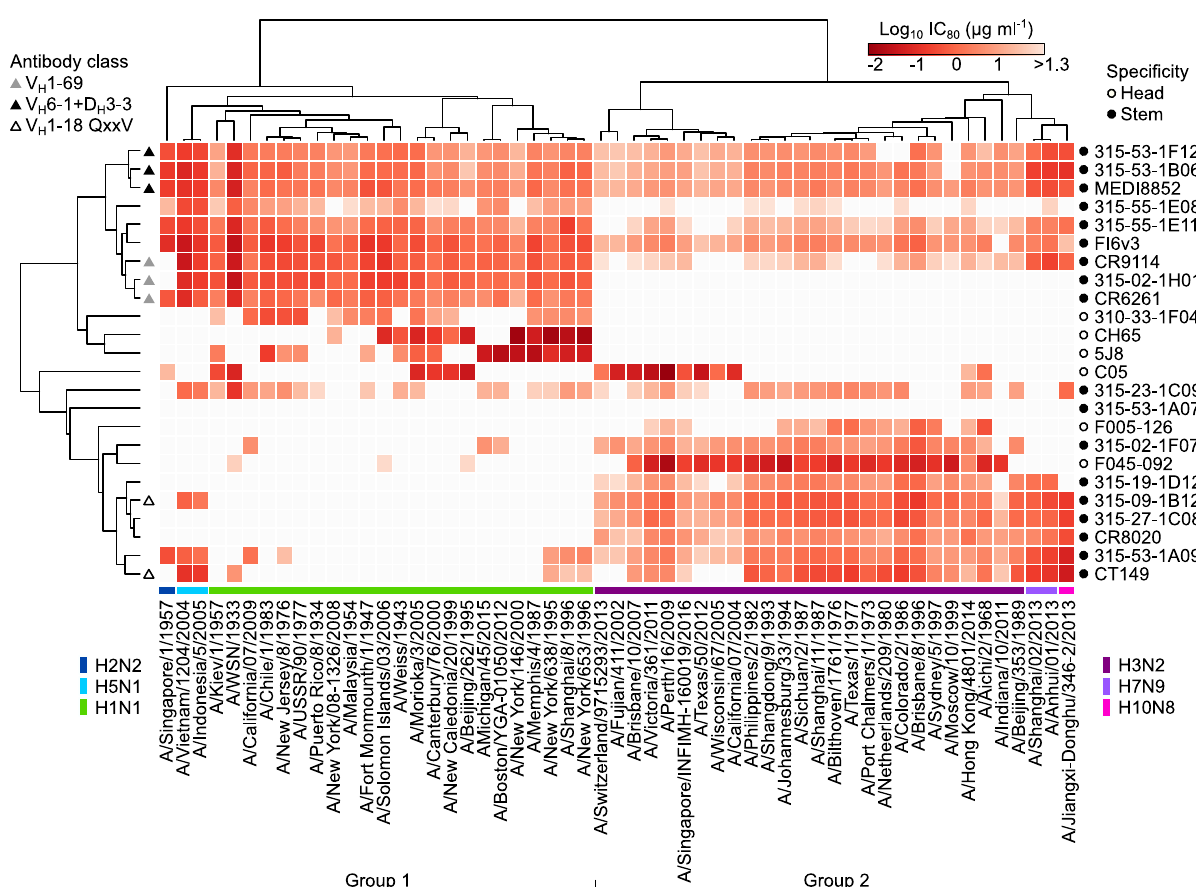
Fig. 5 In-depth neutralization pro fi ling of in fl uenza monoclonal antibodies. Heatmap of neutralization titers (IC 80 μ g ml − 1 ) of 24 monoclonal antibodies against a panel of 55 R3 in fl uenza A viruses. Virus subtypes are color-coded and indicated at the bottom of the heatmap. Open and closed circles indicate speci fi city of monoclonal antibodies and are shown on the right of the heatmap (open, HA head-; closed, HA stem-directed). Convergent classes of bnAbs with speci fi c gene signatures are indicated on the left of the heatmap as triangles (gray, V H 1-69; black, V H 6-1 + D H 3-3; open, V H 1-18 QxxV). Heatmap and unsupervised clustering was made with the ClustVis server (https://biit.cs.ut.ee/clustvis/). Note: H1N1 and H3N2 viruses are R3 Δ PB1 and all other viral subtypes are R3 Δ HA viruses. Neutralization assays were performed at least twice and representative data are